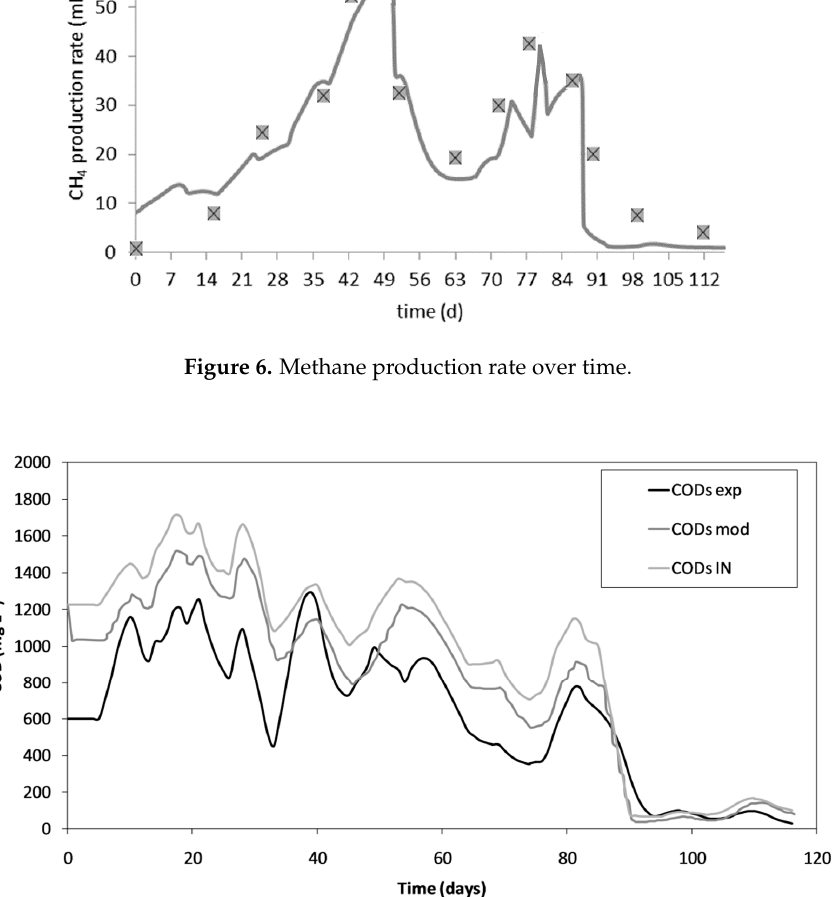
Figure 7. Simulation and observed soluble COD over time.